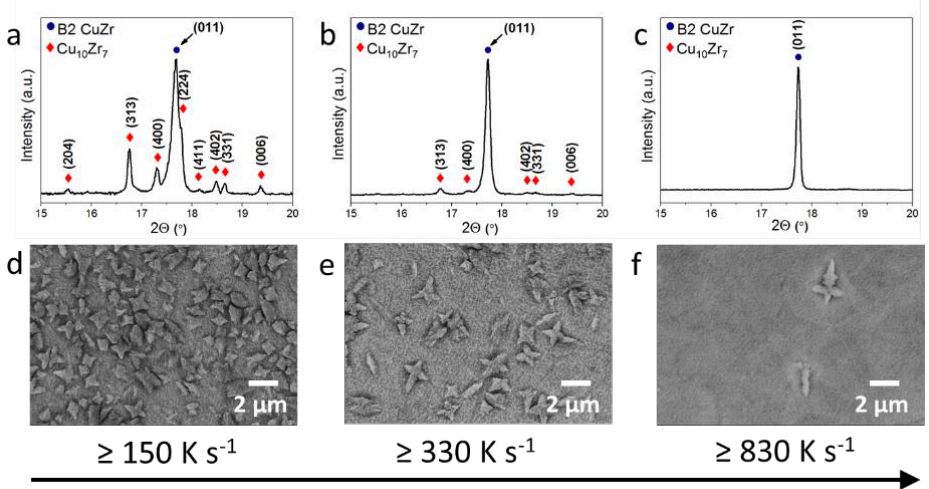
Figure 2. Effect of heating rate on the microstructure of flash annealed Cu 47.5 Zr 47.5 Al 5 metallic glass. XRD patterns ( a – c ) and secondary electron SEM micrographs ( d – f ) of the Cu 47.5 Zr 47.5 Al 5 metallic glass samples rapidly annealed by Joule heating (up to the resistivity drop) with the following current densities: ( a , d ) 34 ± 5 MA m −2 ; ( b , e ) 44 ± 5 MA m −2 ; and ( c , f ) and 59 ± 5 MA m −2 . (Figure 2d is adopted from [20]).